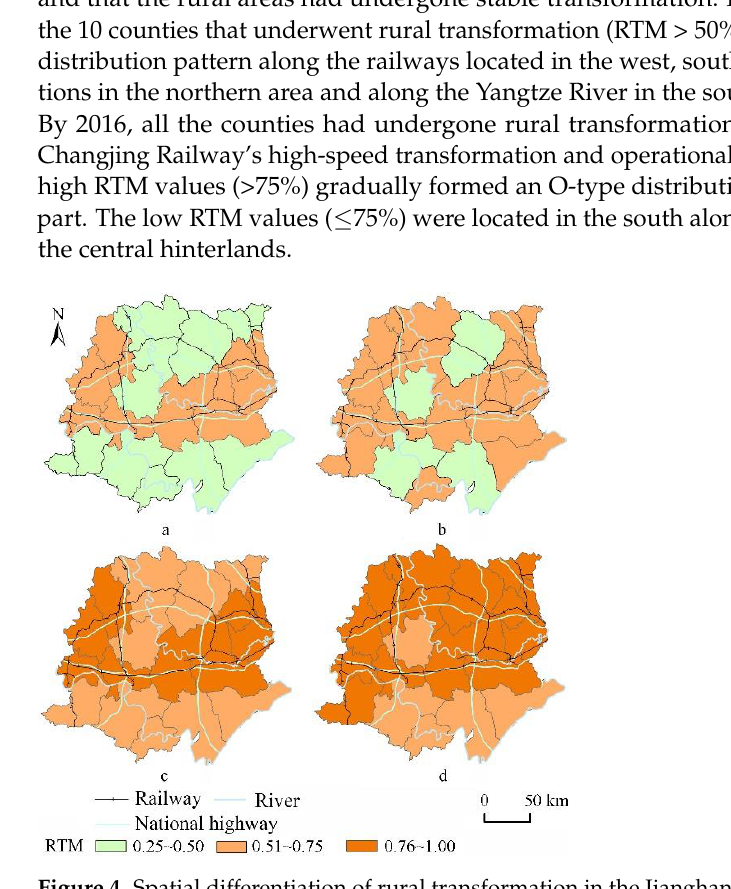
Figure 4. Spatial differentiation of rural transformation in the Jianghan Plain in 2000 and 2016. Note: Red = Undergone transformation; Green = Not undergone transformation. ( a ) 2000, ( b ) 2005, ( c ) 2010, ( d ) 2016.